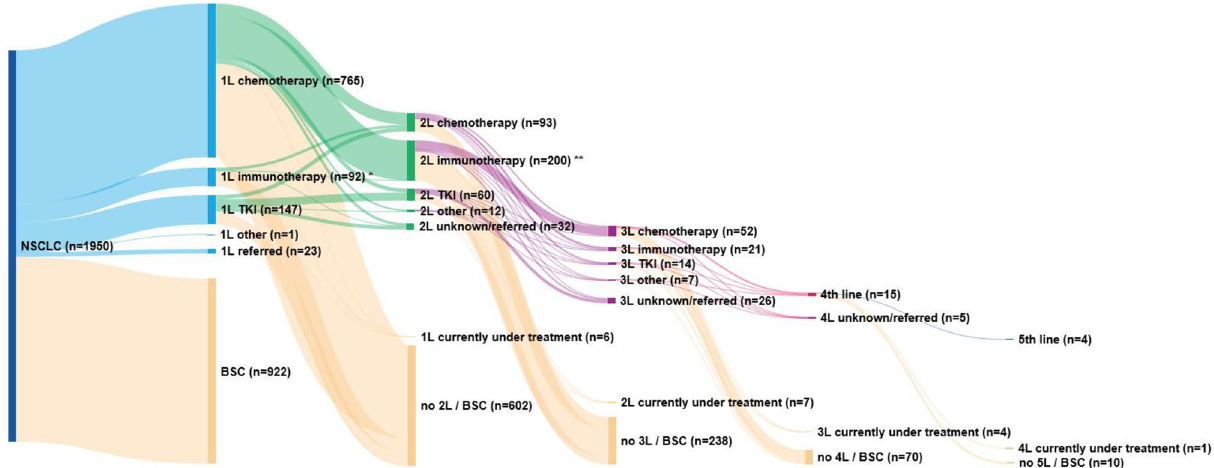
Figure 1. Treatment patterns of patients diagnosed with stage IV NSCLC between 2015 and 2018 in six Dutch hospitals. BSC, best supportive care; TKI, Tyrosine Kinase Inhibitors. *1L immunotherapy: pembrolizumab: n = 83 (90%), nivolumab: n = 3 (3%), other n = 6 (7%). **2L immunotherapy: nivolumab: n = 164 (82%, of which n = 141 with non-squamous histology), pembrolizumab: n = 20 (10%), atezolizumab: n = 13 (6.5%), other: n = 3